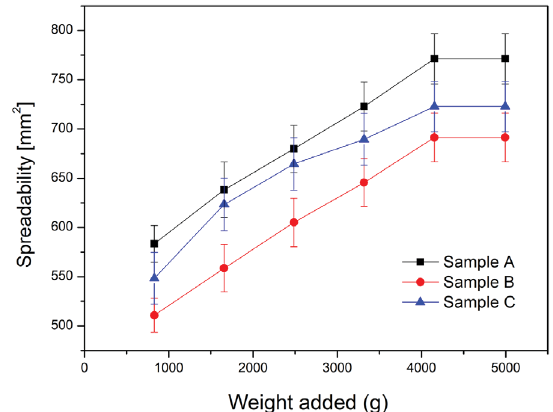
FIGURE 6 - Spreadability profile for